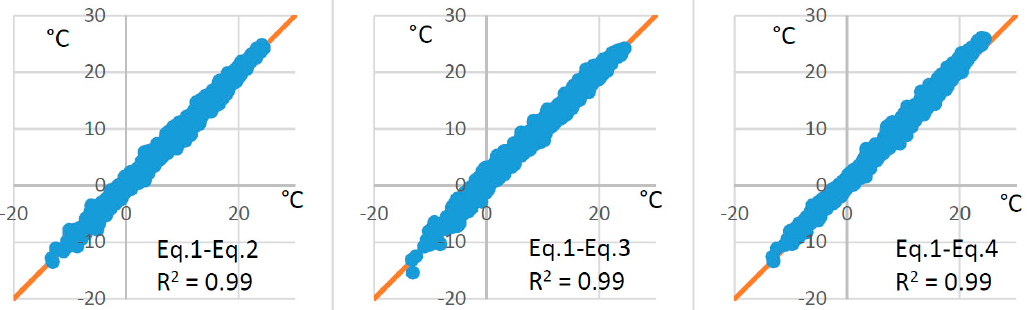
Figure 6. Comparison of mean daily air temperature values for the Rate č e station on the Sava Dolinka river using different input values for the mean air temperature estimates. In all three cases, the x-axis shows the mean daily air temperature estimates using Equation (1) while the y-axis show values obtained using Equation (2), Equation (3), and Equation (4) (from left to right).